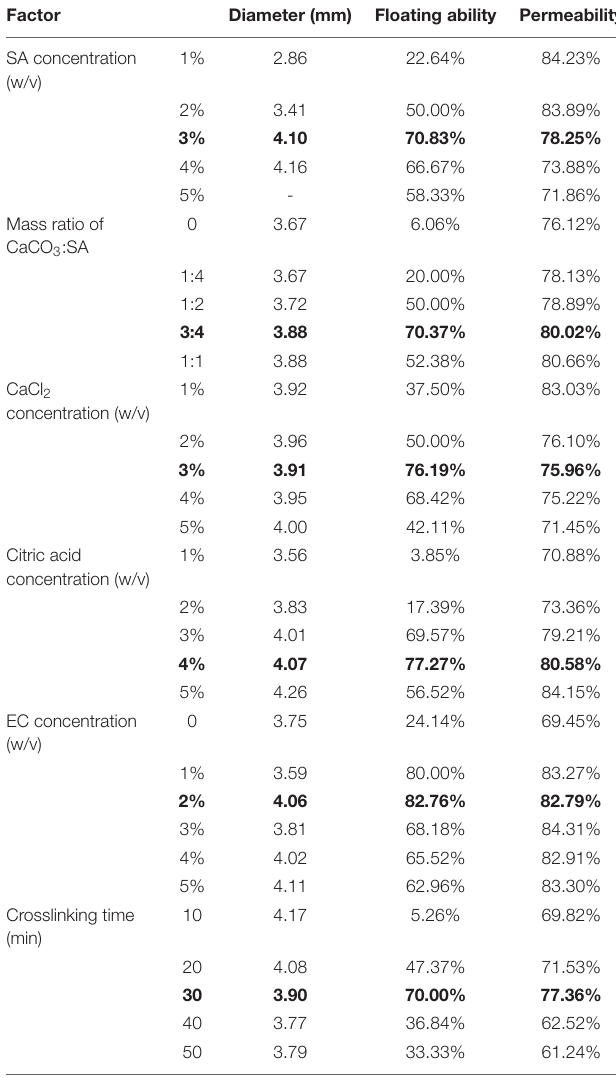
TABLE 1 | Effect of different factors on the properties of the microcapsule (The bold values are for optimized conditions. Factor Diameter (mm) Floating ability Permeability